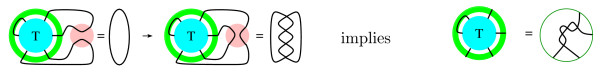
Solving for a 2-string tangle.